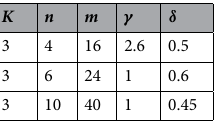
Table 1. Optimal values for γ and δ for various